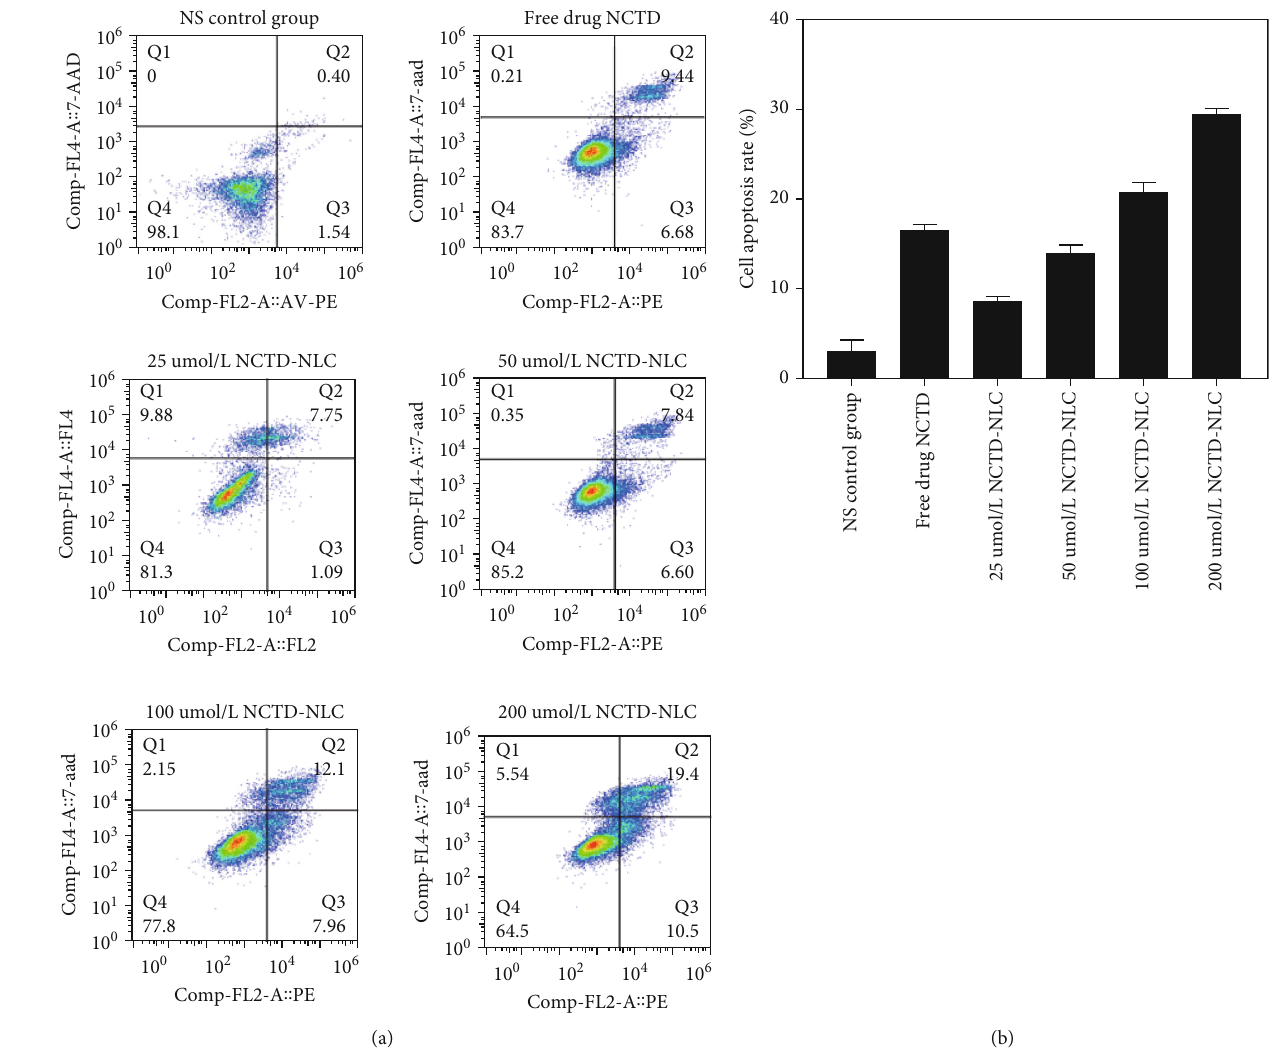
Figure 2: Flow cytometry assay to estimate cellular apoptosis: (a) fl ow cytometry results of apoptosis detection; (b) statistical